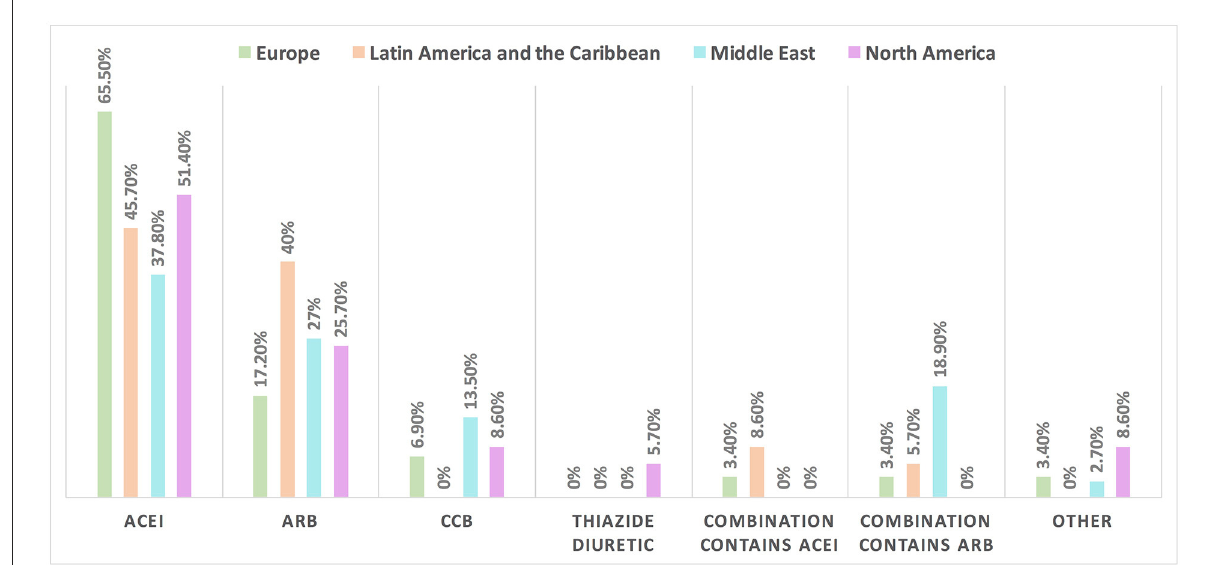
FIGURE4 The most common treatment for hypertension not induced by cancer therapies among patients with cancer in different continents. ACEI is the main antihypertensive agent used for the management of hypertension not induced by cancer therapy. The use of combination treatment containing ARB was found most commonly in the Middle East. ACEI, angiotensin-converting enzyme inhibitor; ARB, angiotensin receptor blocker; CCB, calcium channel blocker.